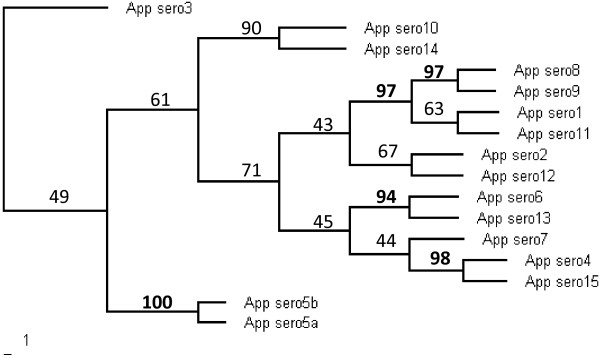
Hierarchical clustering of A. pleuropneumoniae reference strains based on M-CGH data excluding phage and transposase genes. The dendrogram was produced using the MEV software from the J. Craig Venter Institute with Euclidean distance and average linkage clustering (n = 1000 bootstrap iterations).